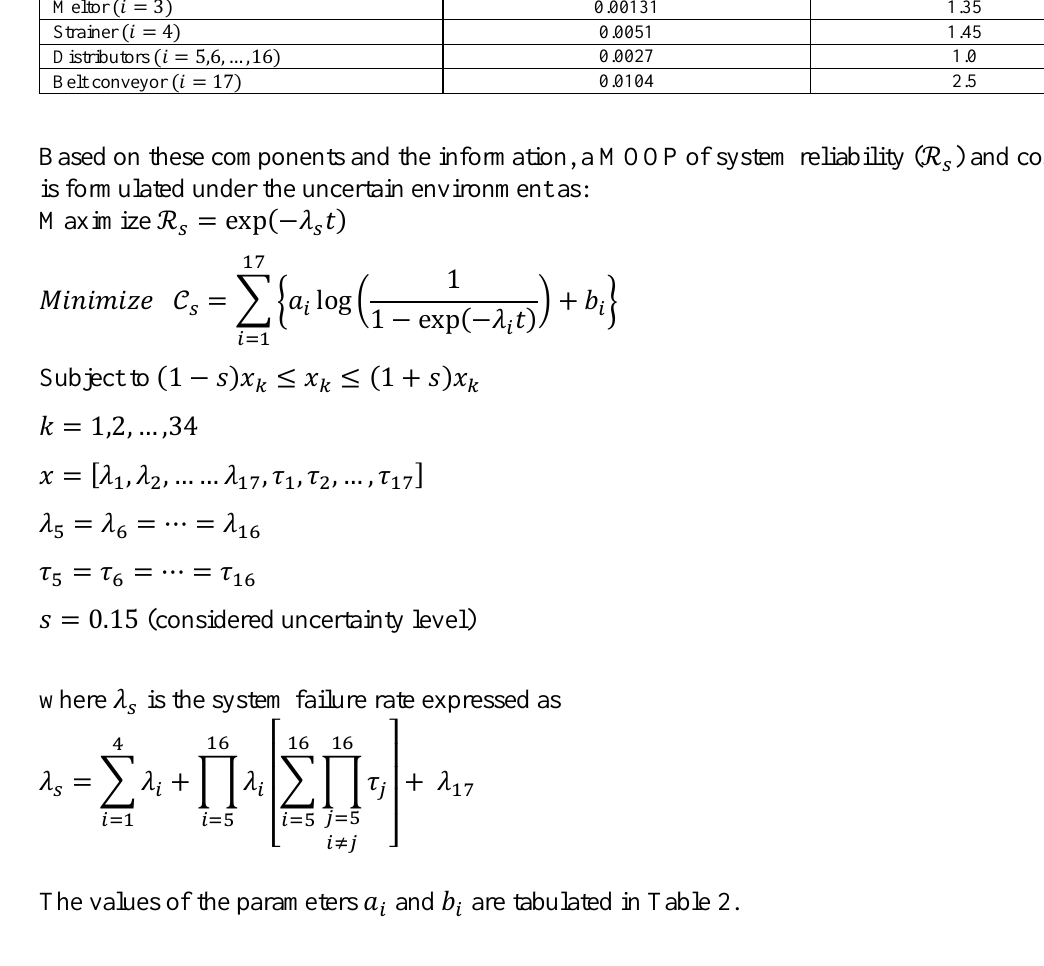
Table 2. Values of 𝑎